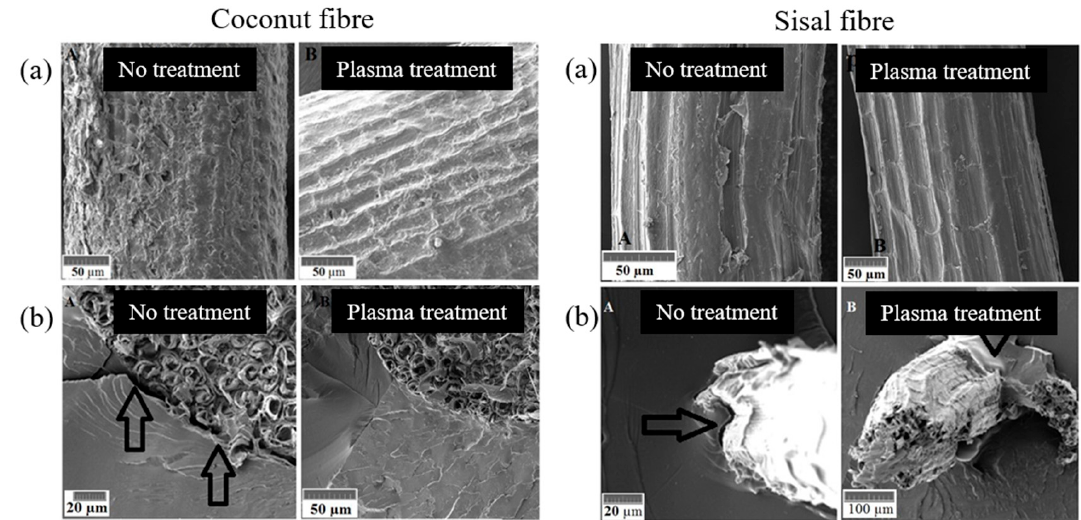
Figure 4. The effect of plasma treatment on ( a ) the surface roughness of fibres and ( b ) the interfacial interaction between the fibre and matrix [126].